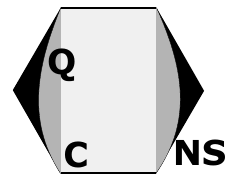
Figure 3: Schematic figure of the probability tables (“behaviors”) that can be realized within classical probability theory ( ), within quantum physics ( ), or within any C Q non-signalling probabilistic theory ( ). In the case of ( m , n , k ) = ( 2,2,2 ) , these N S convex sets are eight-dimensional; the 16 parameters in P ( a , b | x , y ) are reduced by the normalization and no-signalling equalities to 8 free parameters. Both and C N S are polytopes, and the extremal points of (which are also extremal points of C Q and ) are the deterministic non-signalling probability tables. In contrast to and N S C , the quantum set is not a N S Q